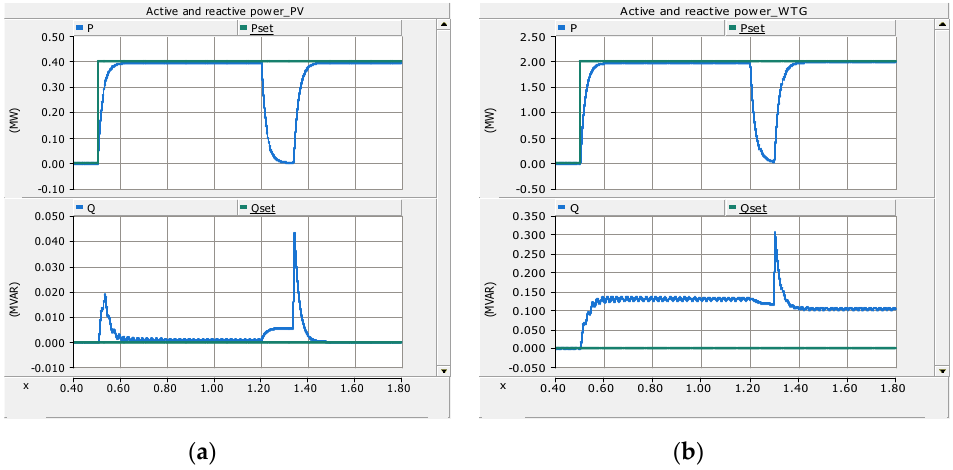
Figure 21. Active (P) and reactive (Q) power supply from DGs before, during and after fault F2 in the islanded mode: ( a ) P and Q from the PV system and ( b ) P and Q from the WTG.